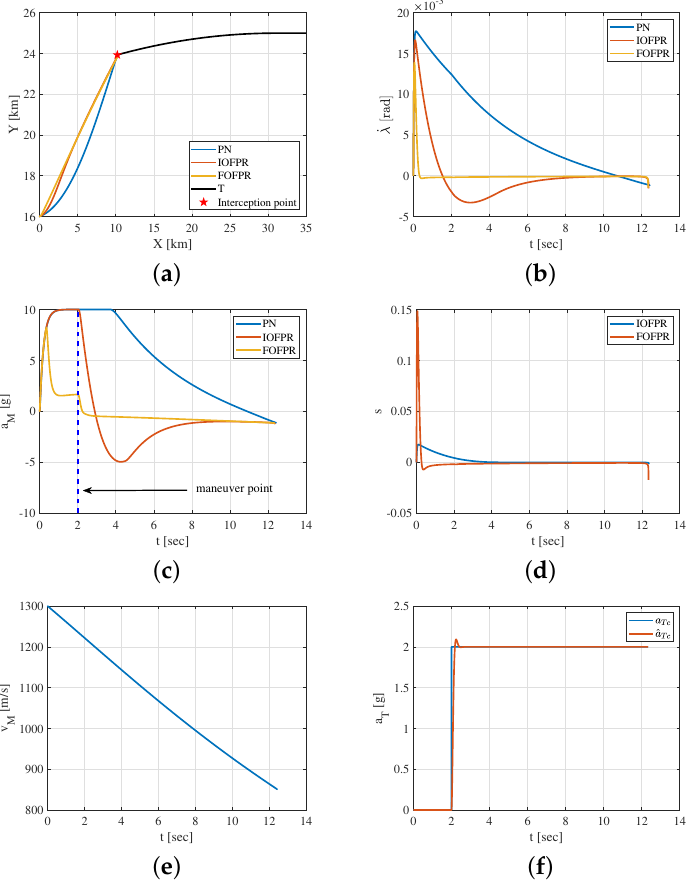
Figure 3. Interception results of the bang-bang maneuver mode. ( a ) Trajectory; ( b ) LOS angular rate; ( c ) acceleration command; ( d ) sliding surface; ( e ) speed; ( f ) acceleration command of the hypersonic